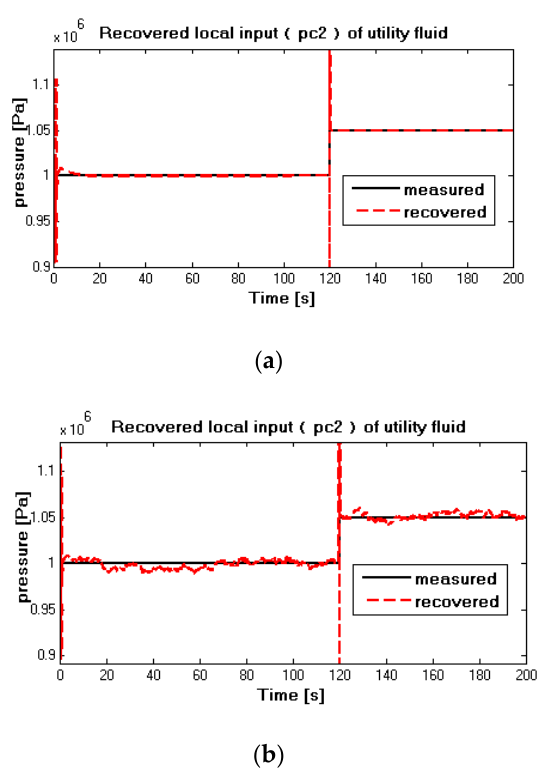
Figure 15. ( a ) Measured and recovered p c 2 (noise-free situation) in case 2; ( b ) measured and recovered p c 2 (noise-corrupted situation) in case